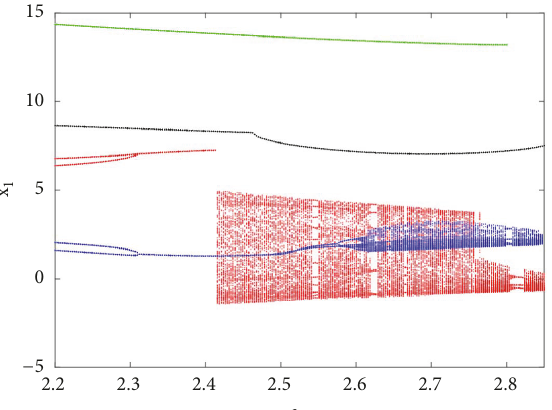
Figure 12: Bifurcation diagram for illustrating the coexistenceof seven different attractorsin the phase space. The diagrams are plotted using the same methods as in Figure